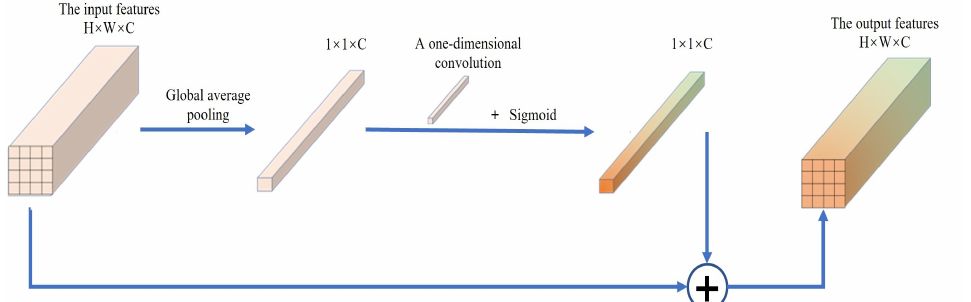
Figure 6. Structure of the ECA module; “+” means that the output results of the previous stage are added. Sigmoid is used as the activation function of the neural network for the output of hidden layer neurons, and the value range is (0, 1).